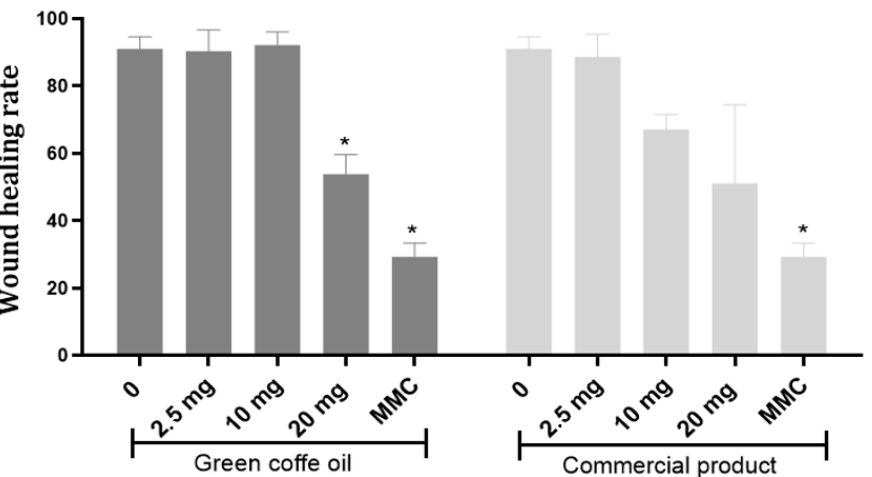
Figure 6. Wound healing rate after treatment with green coffee oil for 48 h. * Significantly different from the negative control ( p < 0.05). The assay was performed in triplicate.